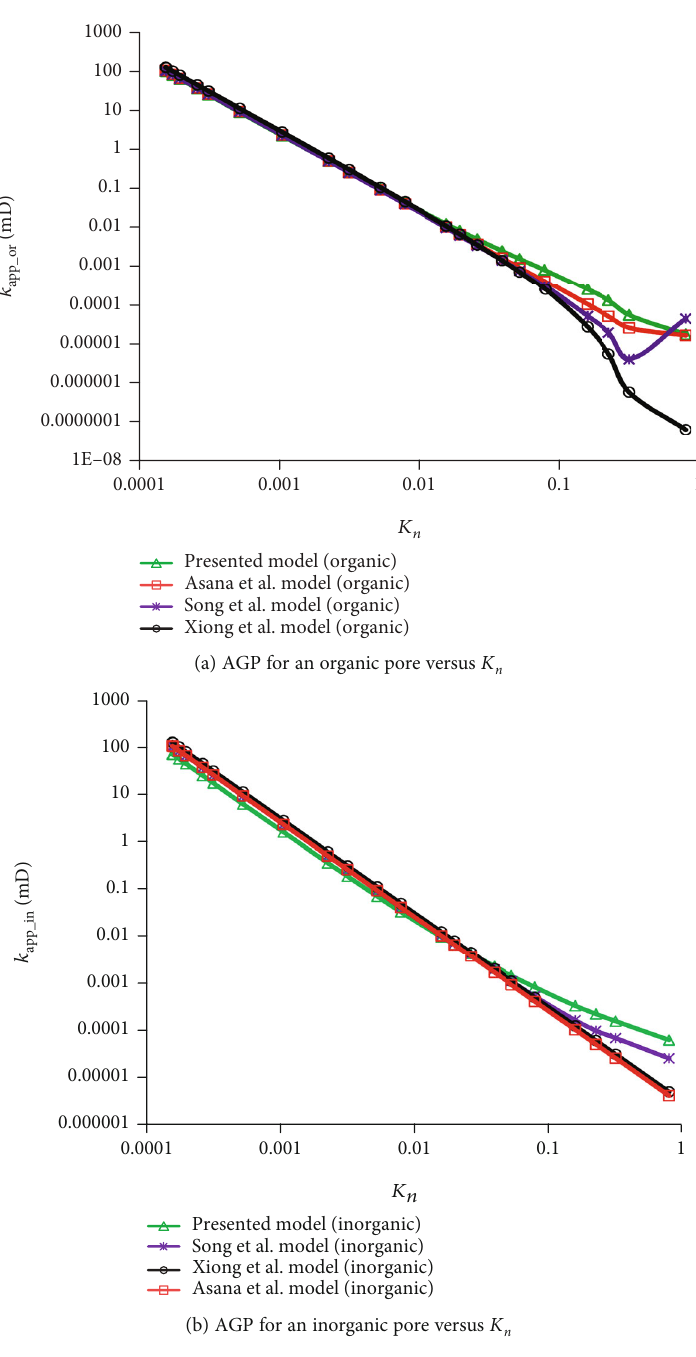
Figure 3: Comparison of organic and inorganic matters with other models ( p = 30 : 9 MPa, T = 412